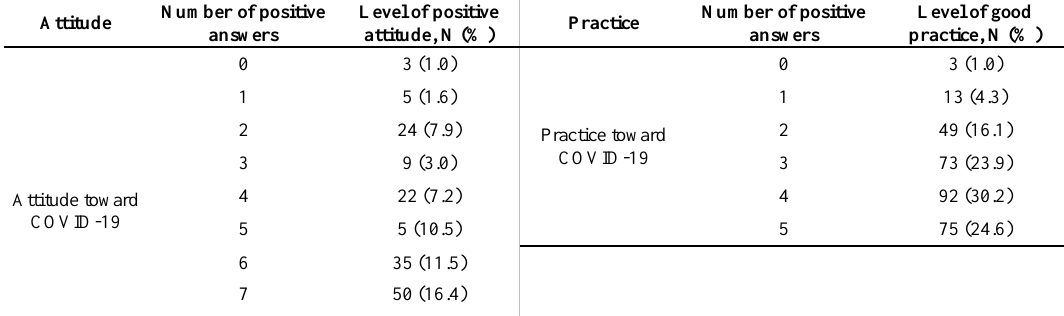
Table 6. Level of positive attitude and good practice on COVID-19 among university